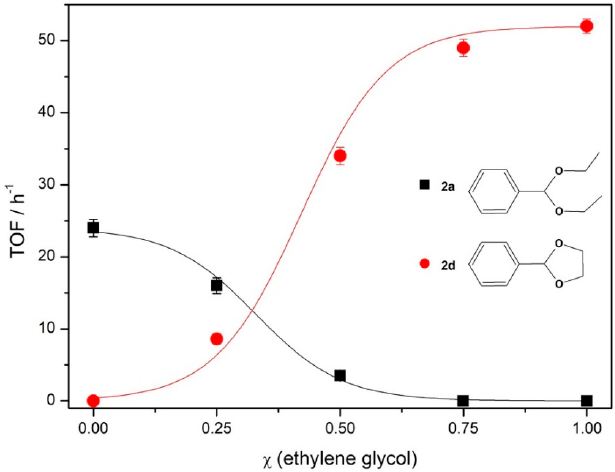
Figure 3. TOF values (h − 1 ) for 2a ( ▪ , black) and 2d (•, red) conversion in the function of ethylene glycol